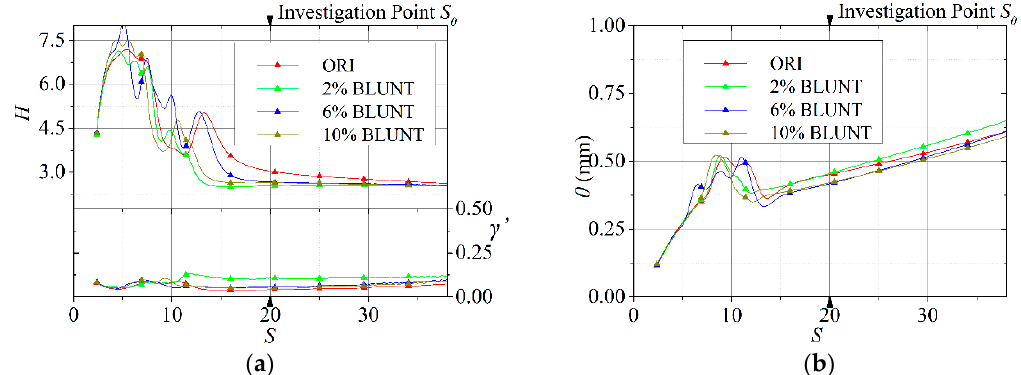
Figure 5. The BLUNT of Ellip.LE at Tu = 0: ( a ) the boundary layer shape factor and normal average turbulence intermittency; ( b ) the momentum thickness along aerofoils.